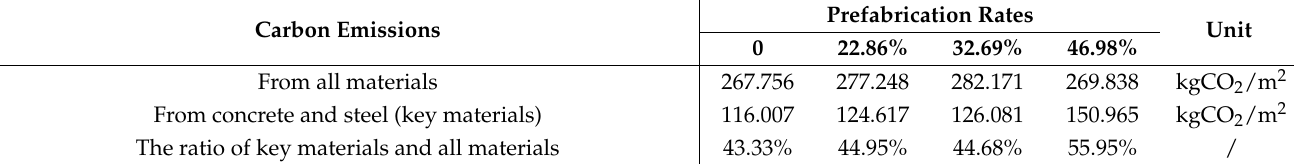
Table 12. Carbon Emissions of Key Materials under Different Prefabrication Rates.